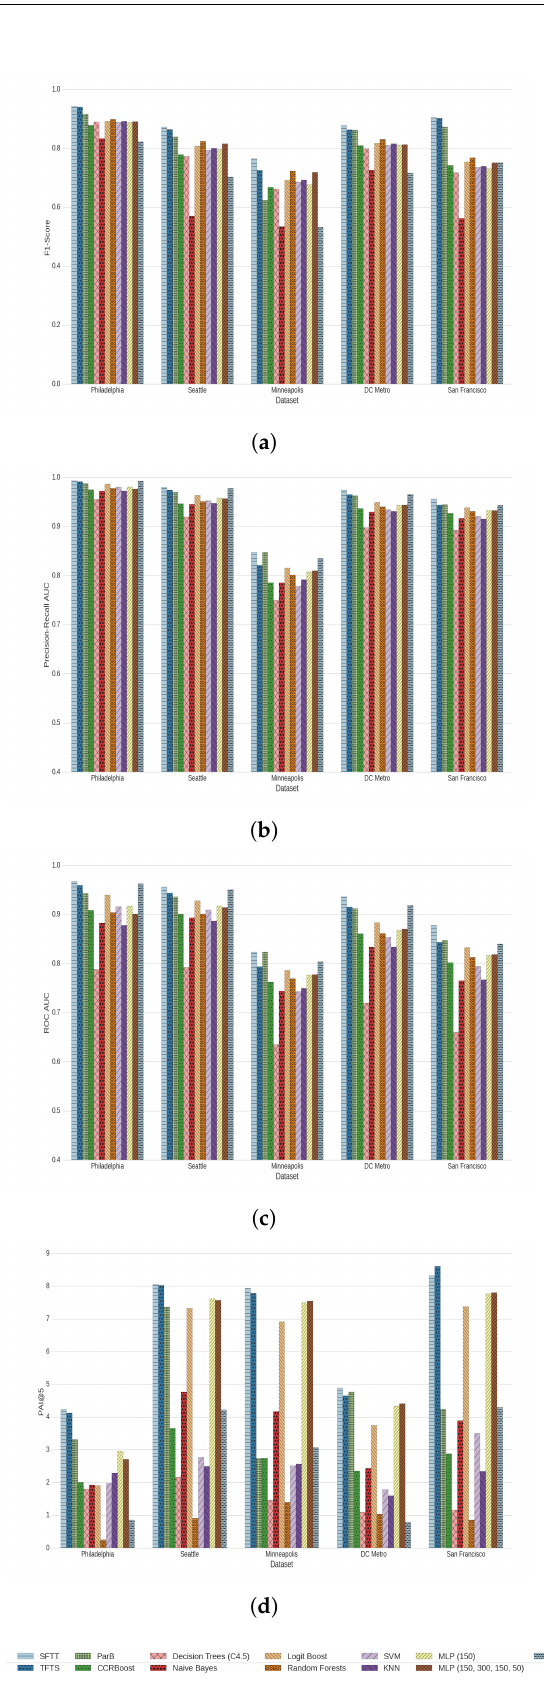
Figure 4. ( a ) F1score, ( b ) PR AUC, ( c ) ROC AUC and ( d ) PAI@5 per dataset for “All Crimes” crime type for the 3 DL models and 10 baseline approaches for a cell size of 450 m (40 by 40). Best viewed in